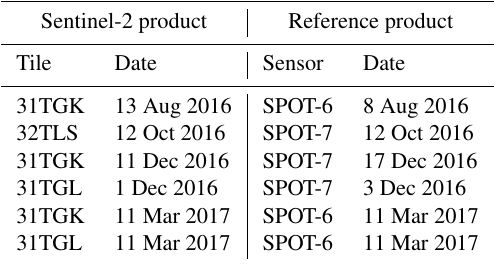
Table 4. Pairs of Sentinel-2 and SPOT-6/7 products used for the evaluation of the snow detection accuracy (see also Fig.